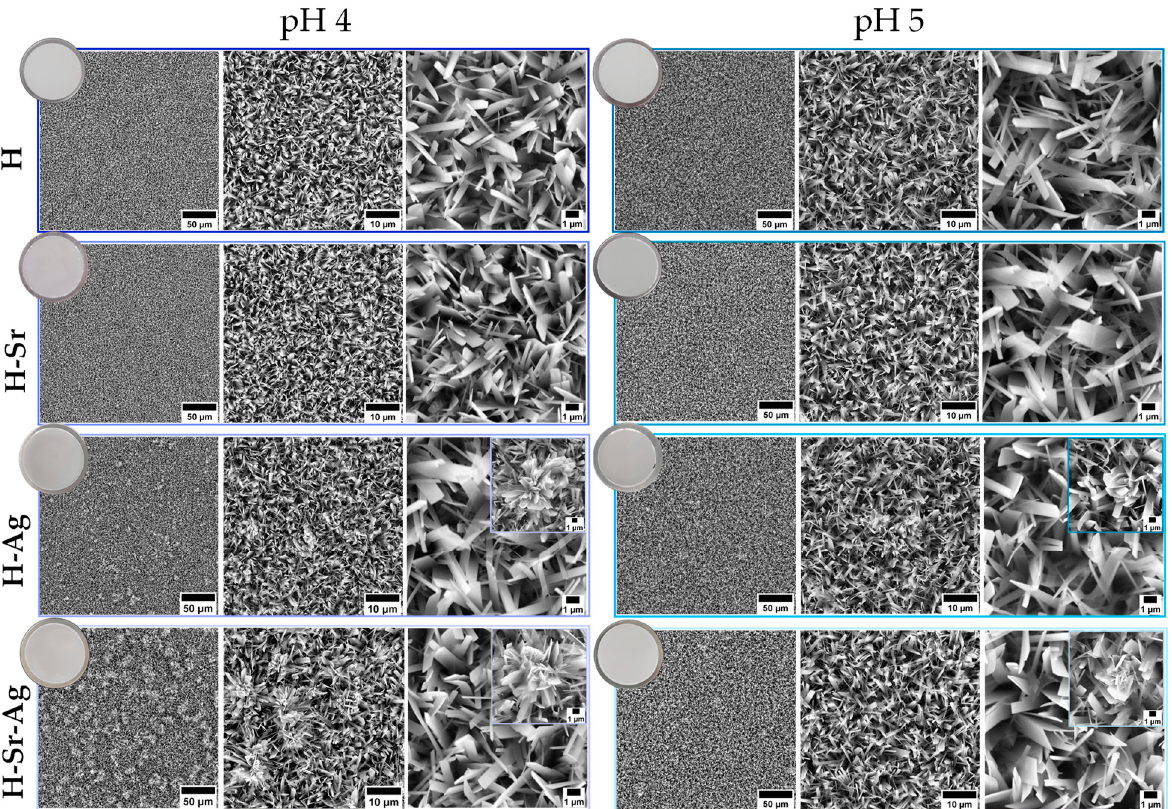
Figure 2. SEM images of hydroxyapatite-based coatings, and macroscopic images of samples after deposition (round shape).